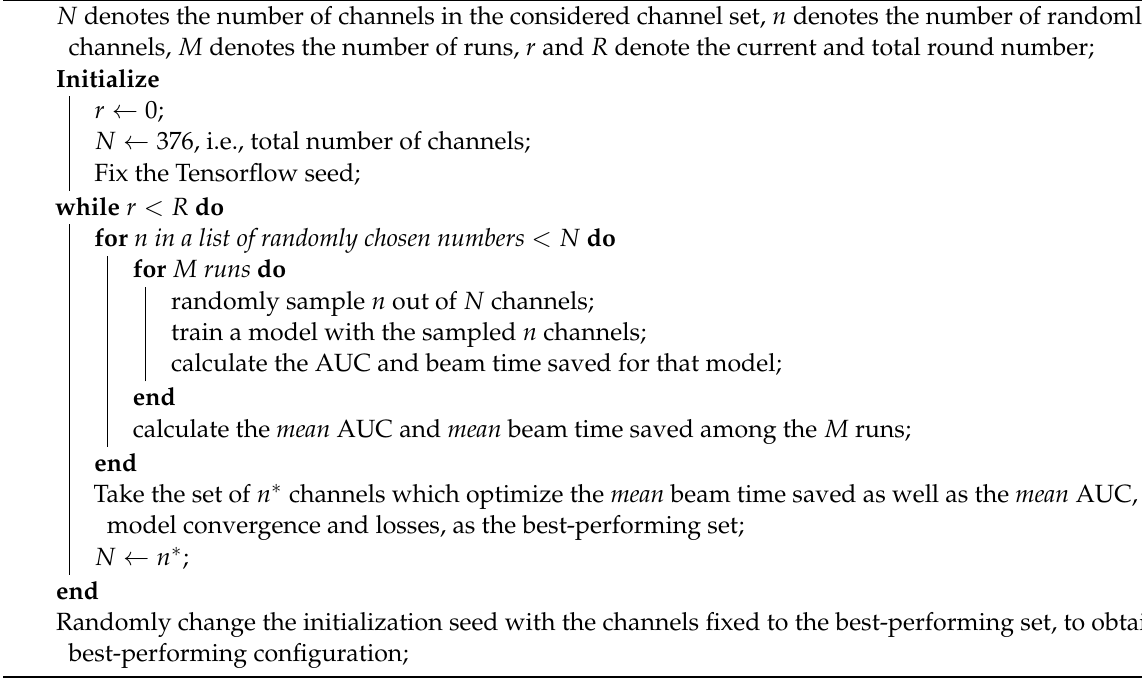
Algorithm 1: Random feature